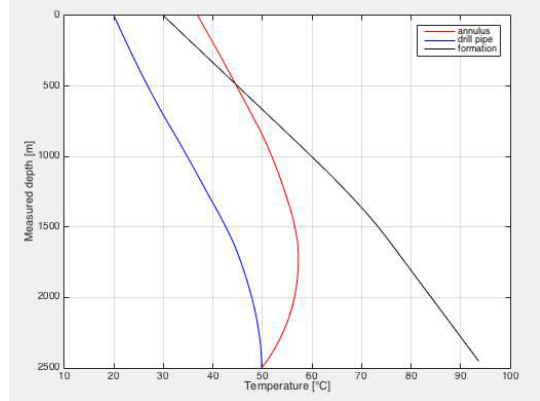
Figure 2: Temperature distribution( Q = 500 l/min )